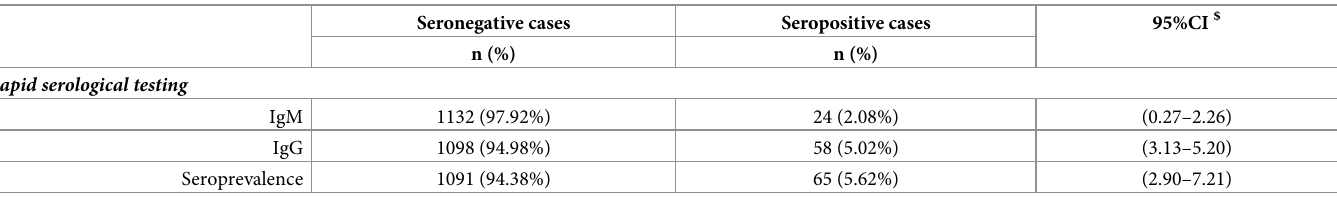
Table 2. Rapid serological testing results for SARS-CoV-2 (N =